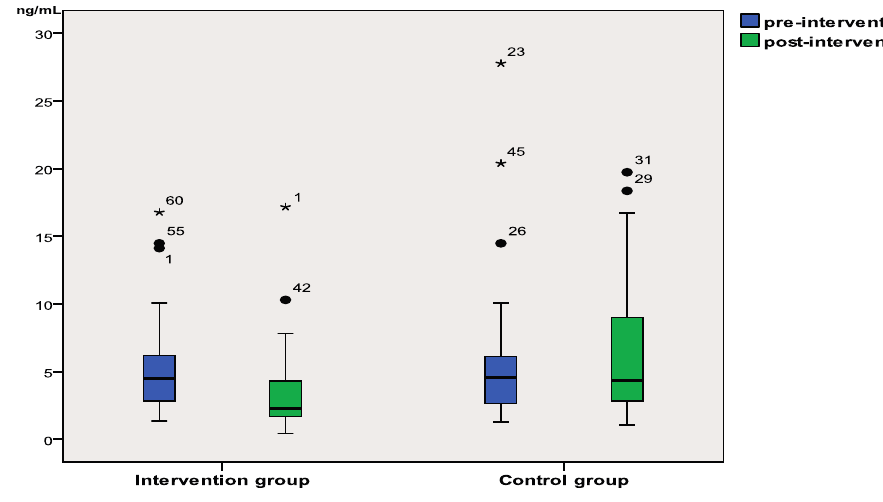
Figure 2. Children’s urinary cotinine levels at the baseline and after the 6-month follow-up period in the intervention and control groups (dot and star represent the